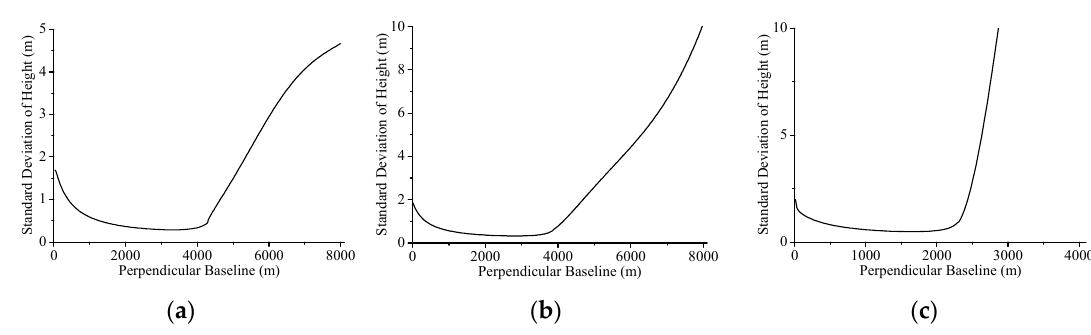
Figure 10. Standard deviation of height versus the perpendicular baseline. ( a ) Corresponding to Figure 7(a) and (d); ( b ) corresponding to Figure 7(b) and (e); and ( c ) corresponding to Figure 7(c) and (f).